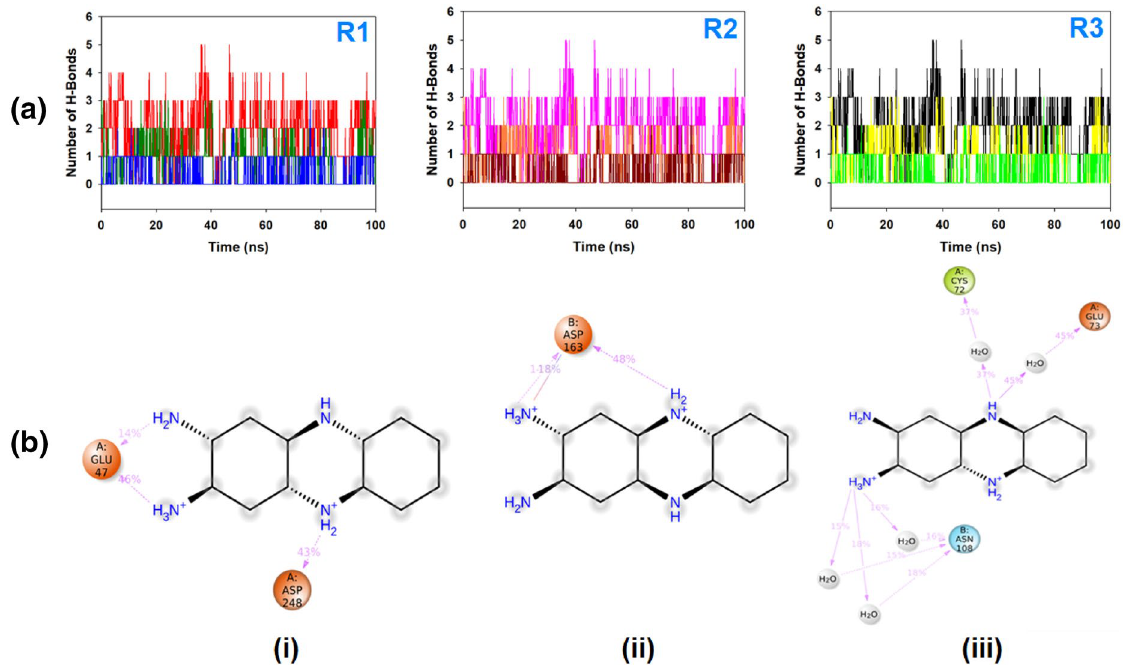
Figure 9. MD simulation trajectory analysis from 100 ns time frame in triplicate displayed ( A ) Number of hydrogen bonds formed between DAPH + Cl − and proteins during 100 ns simulation R1 (replicate 1) M pro (red), nsp2 (green) and nsp7-nsp8 (blue); R2 (replicate 2) M pro (purple), nsp2 (orange) and nsp7-nsp8 (dark red) and R3 (replicate 3) M pro (black), nsp2 (yellow) and nsp7-nsp8 (parrot green); ( B ) 2D interaction plot of DAPH + Cl − with M pro (left panel), nsp2 (middle panel) and nsp7-nsp8 (right panel) during 100 ns of simulation. Dotted (purple) lines indicate H-bonds, amino acid residues inside sphere and H 2 O displaying water